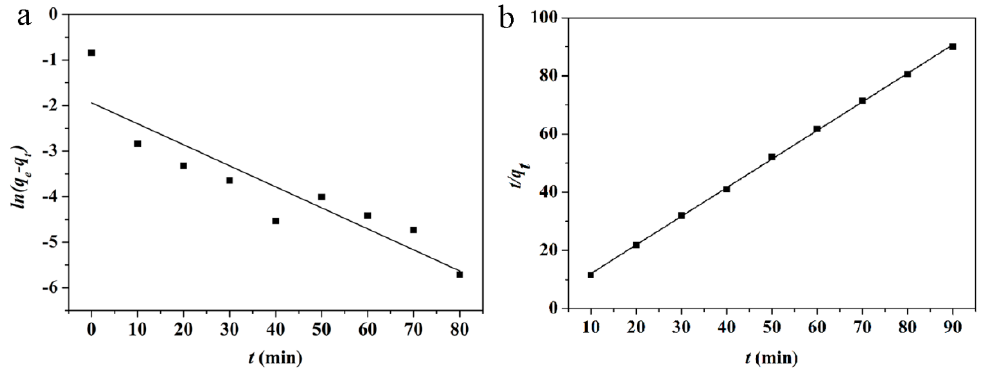
Figure 2. Pseudo-first-order ( a ) and pseudo-second-order ( b ) for CIP adsorption onto HNTs.